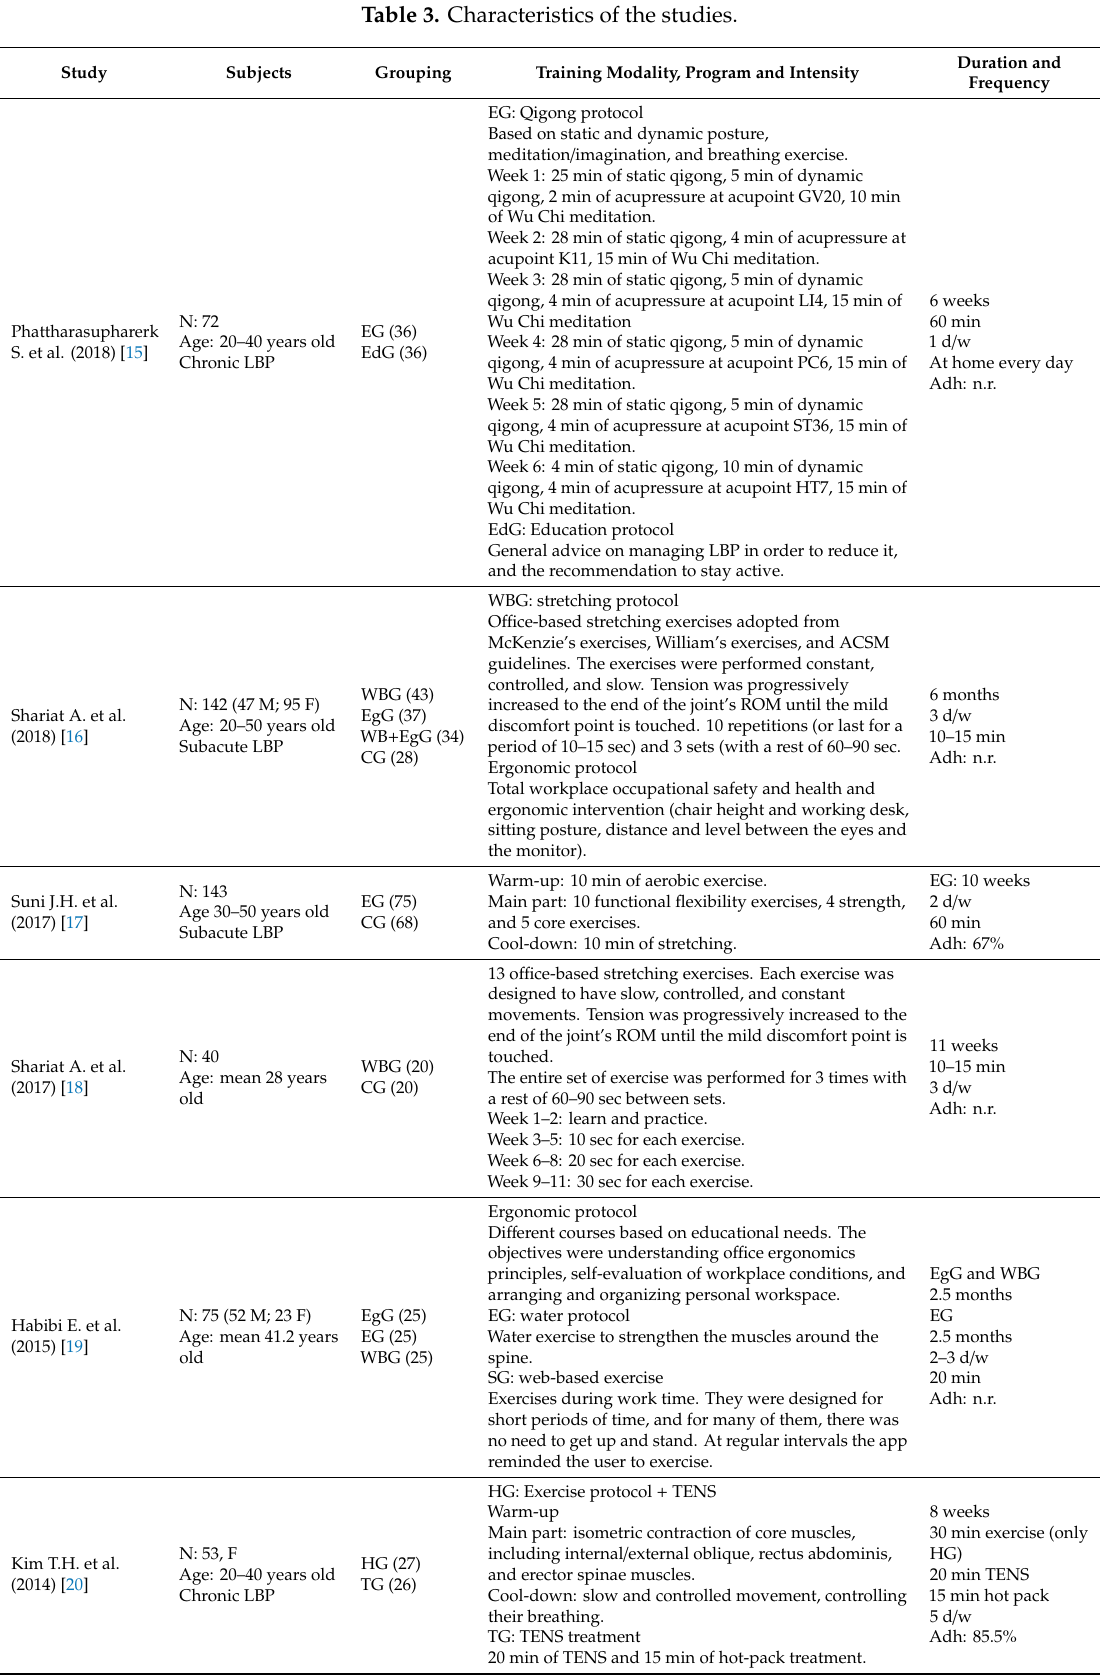
Table 3. Characteristics of the